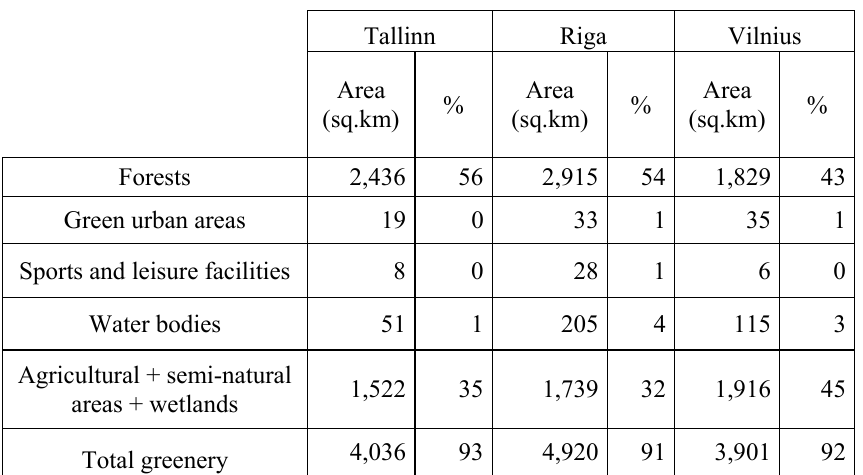
Table 1. Greenery in the FUAs of the Baltic States by Urban Atlas classes (2006 data) (data source: European Comission, 2017d) Tallinn Riga Vilnius Area Area Area % % % (sq.km) (sq.km) (sq.km) Forests 2,436 56 2,915 54 1,829 43 Green urban areas 19 0 33 1 35 1 Sports and leisure facilities 8 0 28 1 6 0 Water bodies 51 1 205 4 115 3 Agricultural + semi-natural 1,522 35 1,739 areas + wetlands Total